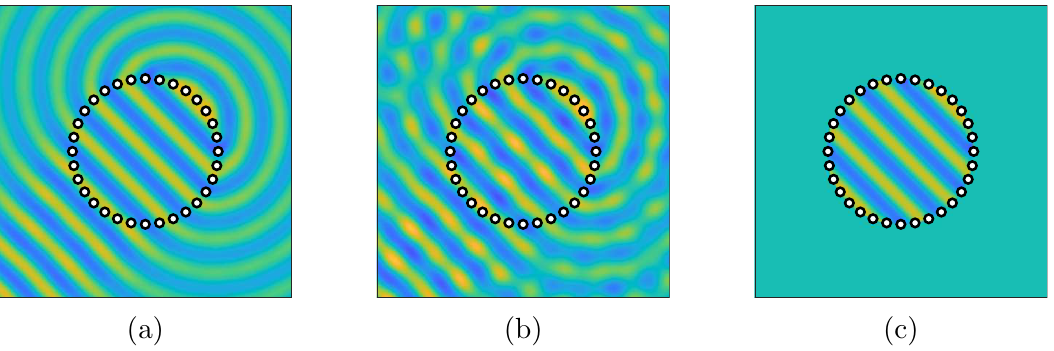
Figure 1. Comparison of two-dimensional sound field syntheses with a circular array: ( a ) typical interior sound field synthesis in a free-field; ( b ) typical interior sound field synthesis in a reverberant environment; and ( c ) undesired propagation-free sound field synthesis in a reverberant